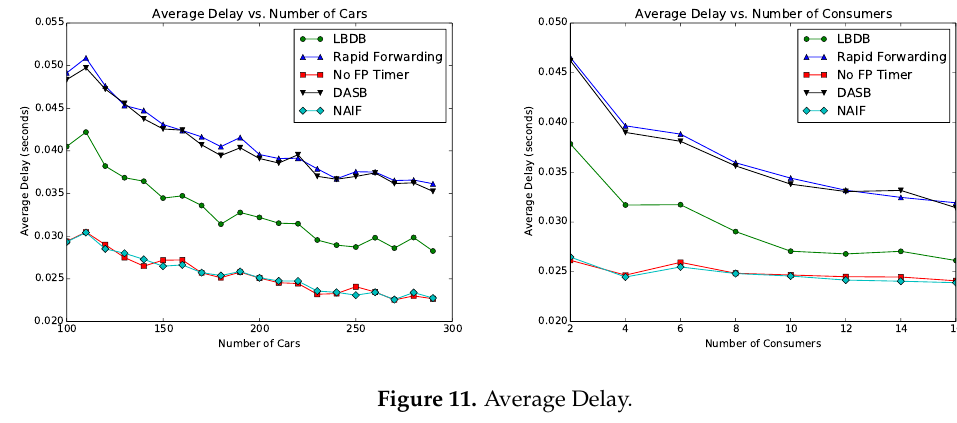
Figure 11. Average Delay.